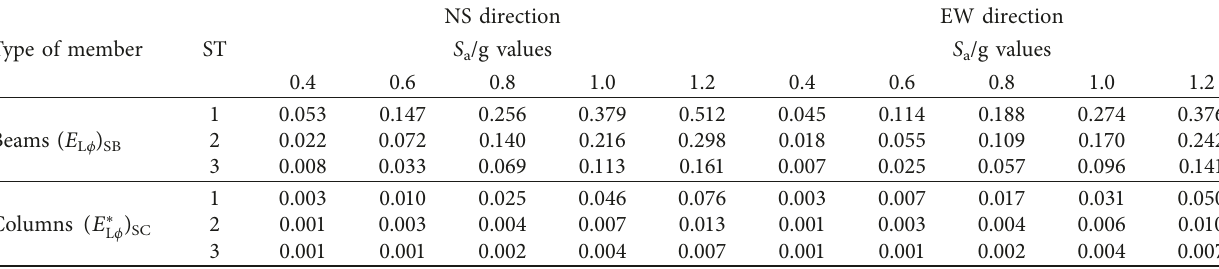
( E ∗ ) L ϕ ) SB and SC , 3-level building. L ϕ